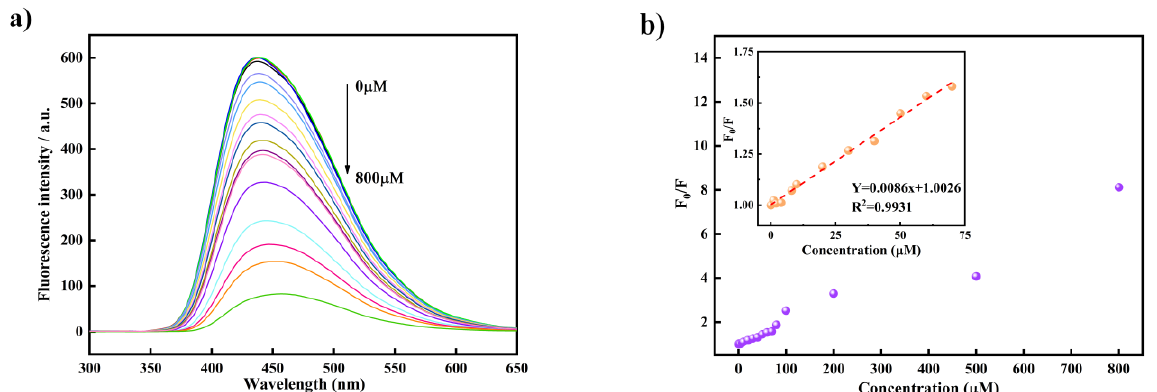
Figure 5. ( a ) The fluorescence emission spectrum of Si, N-CQDs is added with a series of Cr(VI) concentrations. (Illustration: Photograph of non-existent and present Si,N-CQDs of 800 µM Cr(VI) exposed to a 355 nm UV lamp). ( b ) The relative fluorescence intensity (F 0 /F) of Si,N-CQDs is added with different concentrations of Cr(VI). (Illustration: Linear relationship between F 0 /F and Cr(VI) concentration (0–200 µ M)).